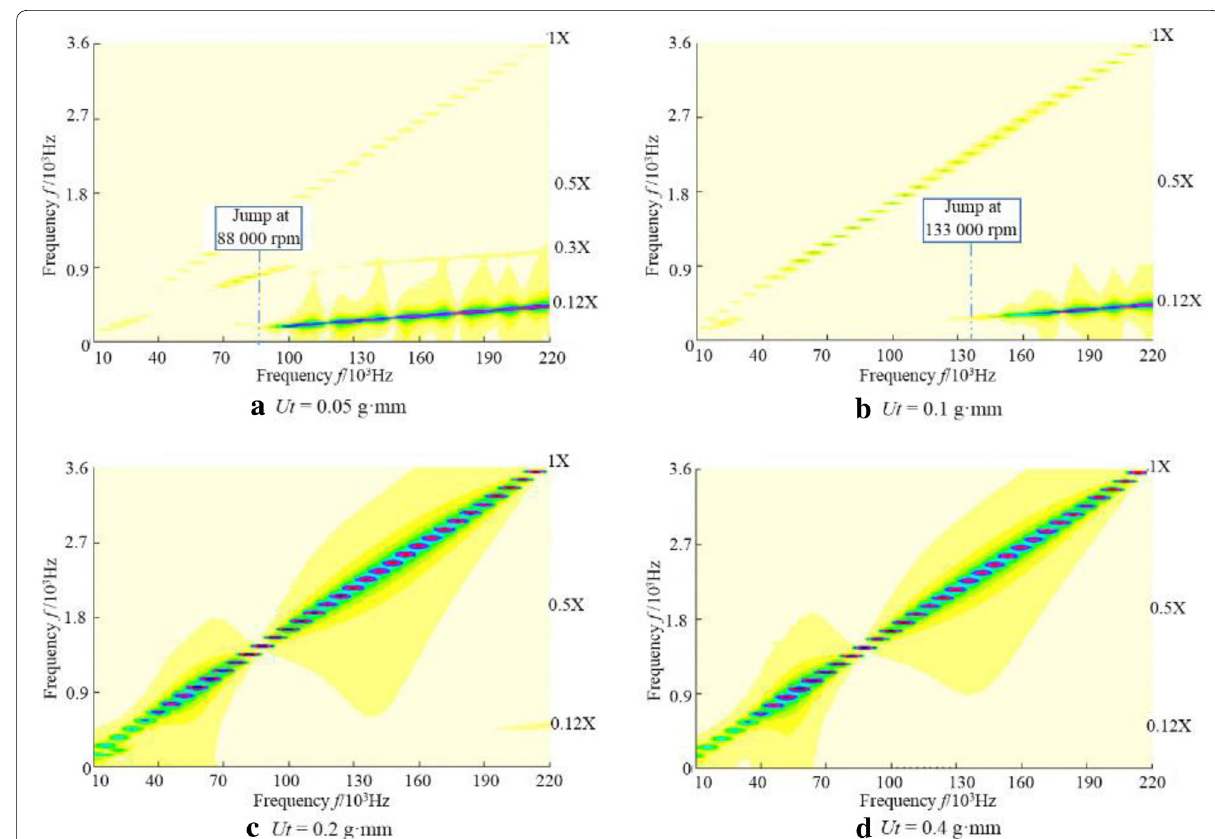
Figure 9 Response spectral intensity plots of stn 20 for four difference unbalance amplitudes in CW nose of